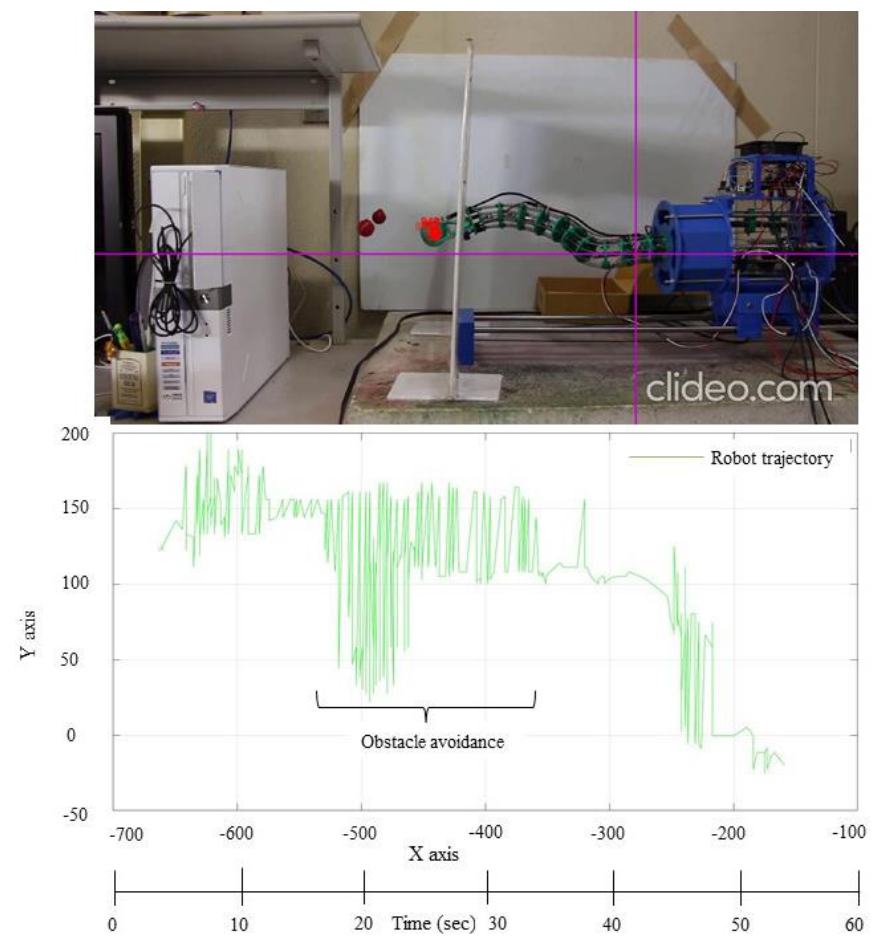
Figure 25. Tomato harvesting experiment timeline and trajectory graph.